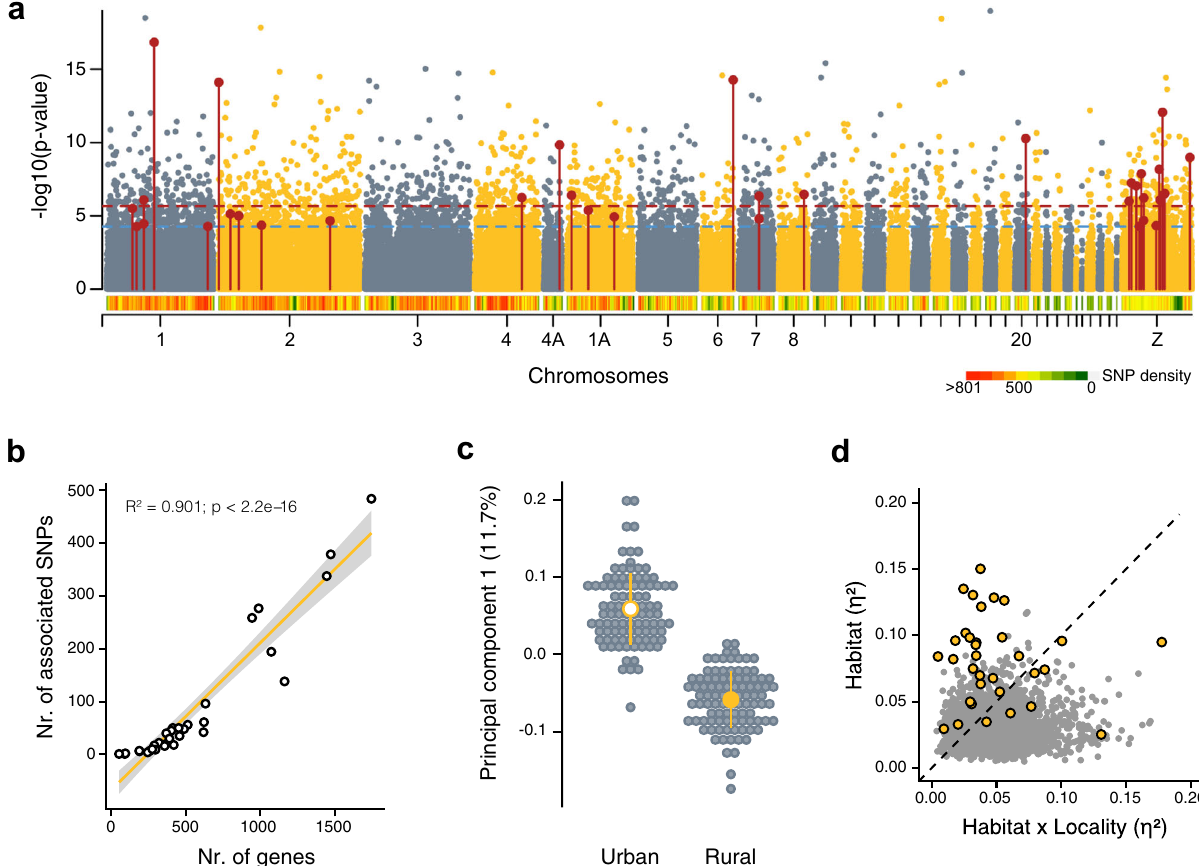
Fig. 3 Genome-wide association with urbanisation. a Manhattan plot showing the genotype – urbanisation (PC urb ) association estimated with LFMM across the genome. The red and blue dotted lines show the 0.1 and 1% FDR signi fi cance thresholds, respectively. Red dots highlight “ core urbanisation SNPs ” that were also identi fi ed as urbanisation associated using BayPass (Supplementary Fig. 6). The heatmap below the Manhattan plot highlights the SNP density across the genome. b Correlation between the number of urbanisation-associated SNPs (from LFMM) and the number of genes per chromosome (linear model: F 1,30 = 284.60, P < 2.2 × 10 − 16 ). Shaded area denotes the 95% CI. c Main axis of variation in a PCA GEA based on “ core urbanisation SNPs ” . Grey circles show individuals, and yellow dots and lines show the mean ± SD for urban and rural populations, n urban = 96 and n rural = 96 independent birds. d Effect sizes (partial η 2 ) for the effects of “ habitat ” (urban vs rural) and “ habitat× locality ” interaction on urban – rural allele frequency, using linear model are shown for all signi fi cant LFMM SNPs on the x -axis and y -axis, respectively. “ Core urbanisation SNPs ” are highlighted in yellow circles. SNPs that lie above the dashed line show strong consistent shifts in allele frequencies across localities, whereas SNPs below the line show more variable allele frequency shifts across localities. Source data are provided as a Source data fi